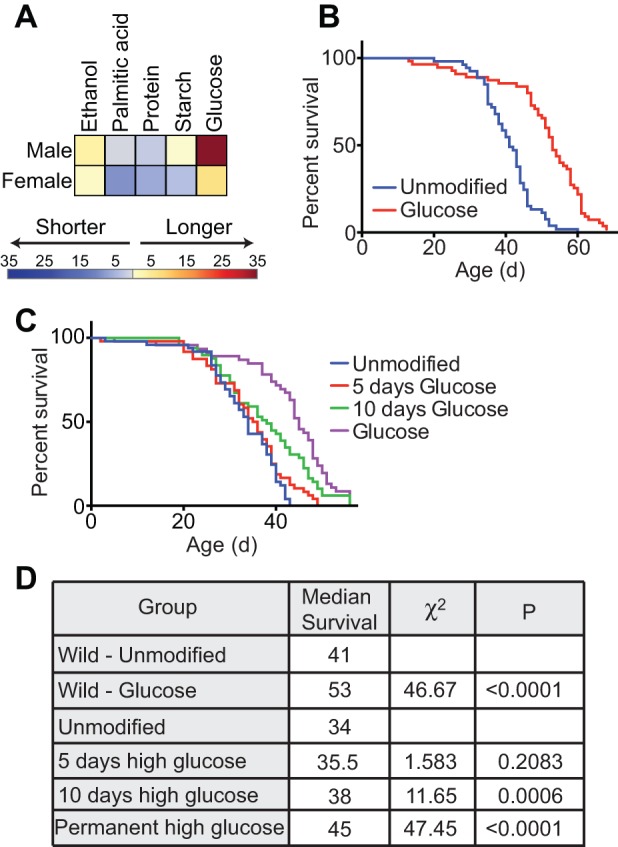
Elevated dietary glucose extends longevity. (A) Heat map summary of Chi-square values from Table 1 showing the effects of the respective diets on the longevity of male and female w1118 flies. Longer values correspond to extended lifespans, and shorter values correspond to diminished lifespans. (B) Survival curves of a wild strain of male Drosophila raised on an unmodified diet or on a diet supplemented with glucose. (C) Survival curves of male w1118 Drosophila raised on an unmodified diet, or on a diet supplemented with glucose for 5 days, 10 days, or permanently. (D) Results of Log-rank (Mantel–Cox) test of data in panel B and C. All χ2 and P values are relative to unmodified.